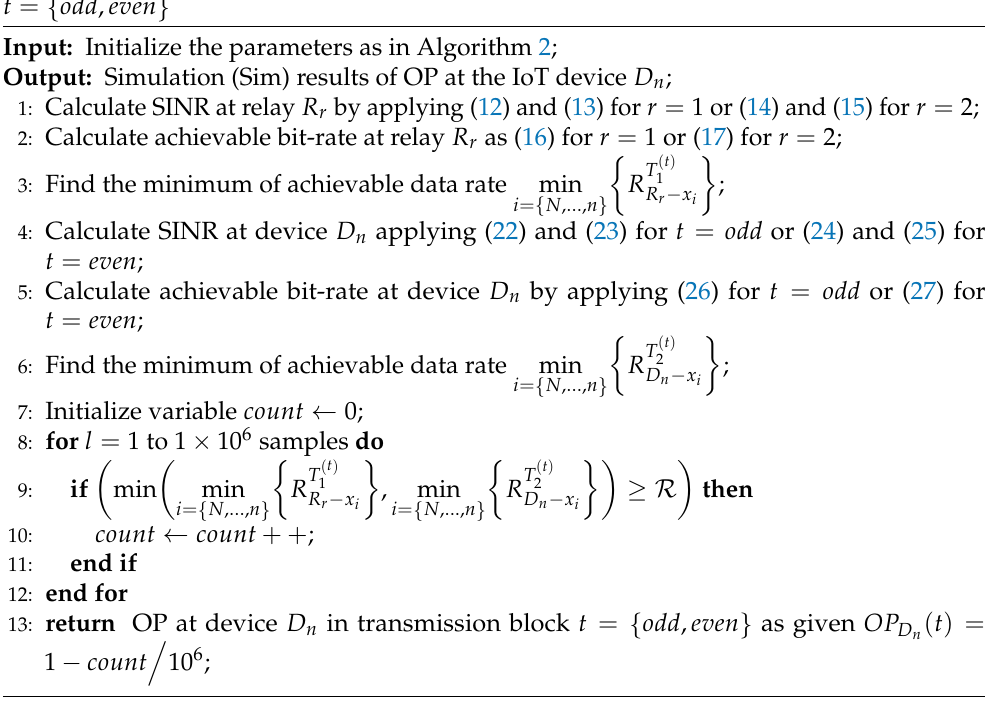
Algorithm 3 Algorithm for investigation OP at IoT device D n in a transmission